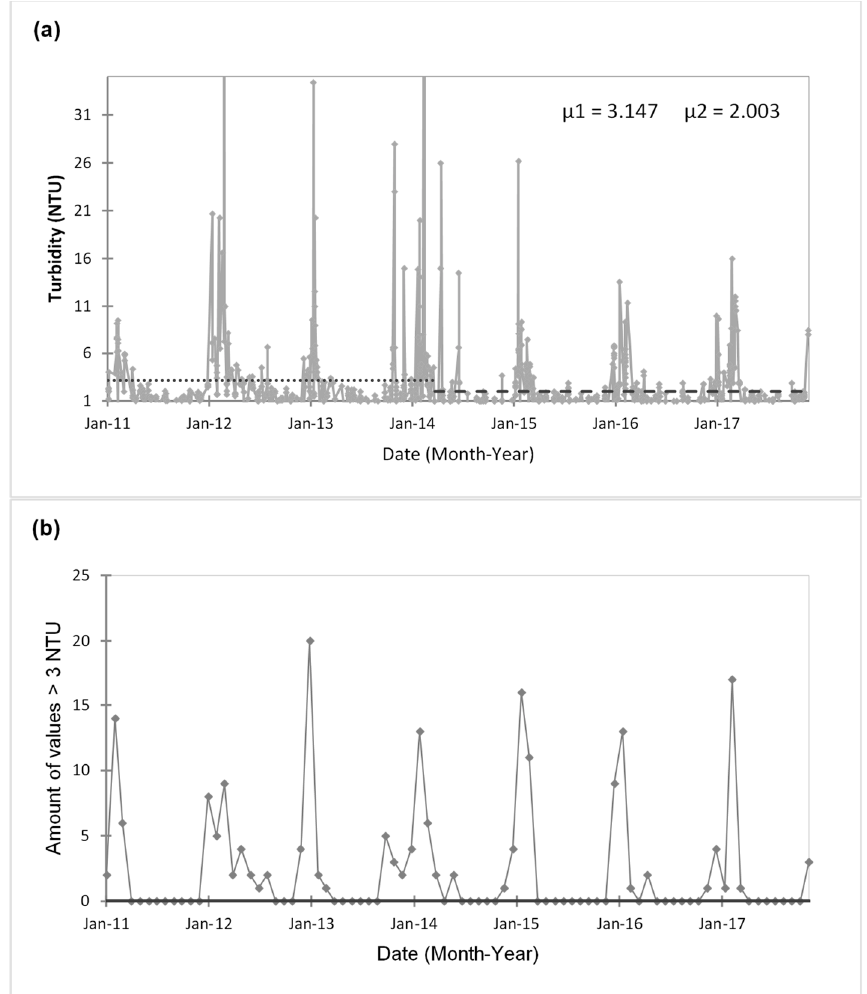
Figure 5. System No. 2. ( a ) Time-series analysis for turbidity values; ( b ) Number of values greater than 3 NTU per month per year. Significant shifts in the means values from the Pettit analysis are indicated by (dotted line) and µ2 (dashed line).